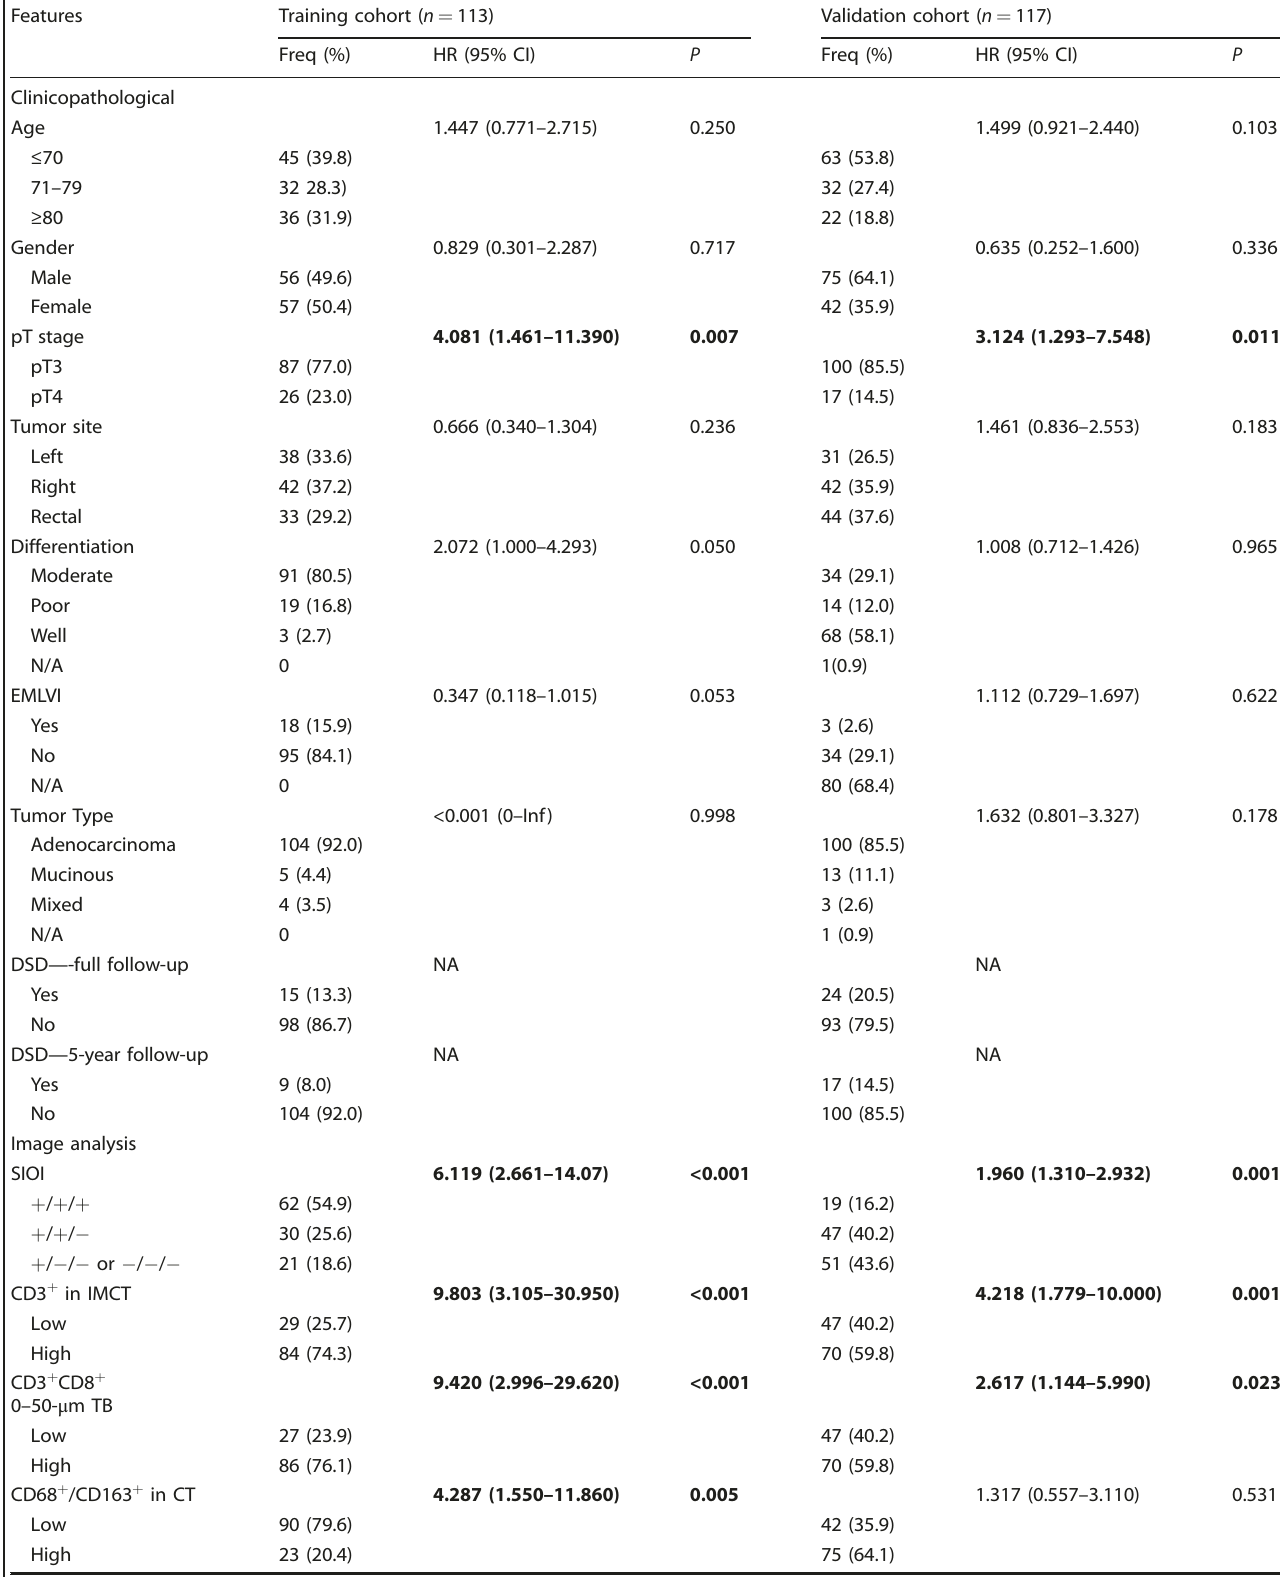
Table 1. Univariate Cox regression analysis for clinicopathological data, SIOI, and SIOI components for the training and validation cohort.